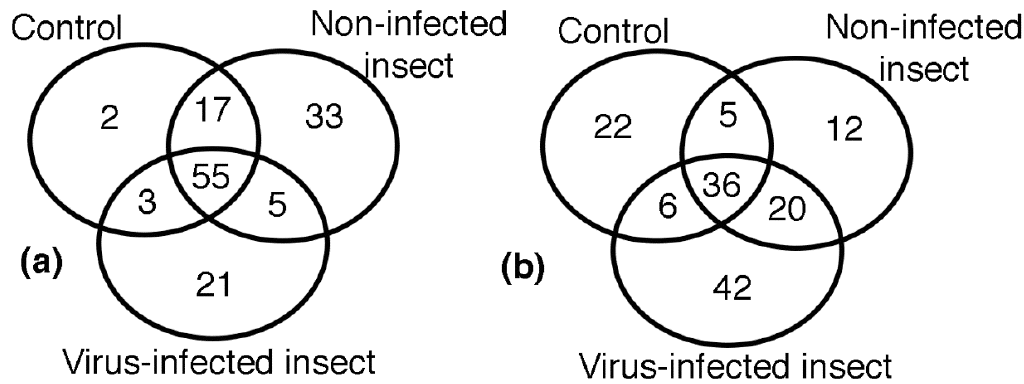
Figure 3. Venn diagram representing differentially expressed spots for the three experimental groups: treatment 1 (control group), treatment 2 (non-infected insect), and treatment 3 (insect infected with RHBV). ( a ) Fedearroz 2000 variety; ( b ) Colombia I variety.